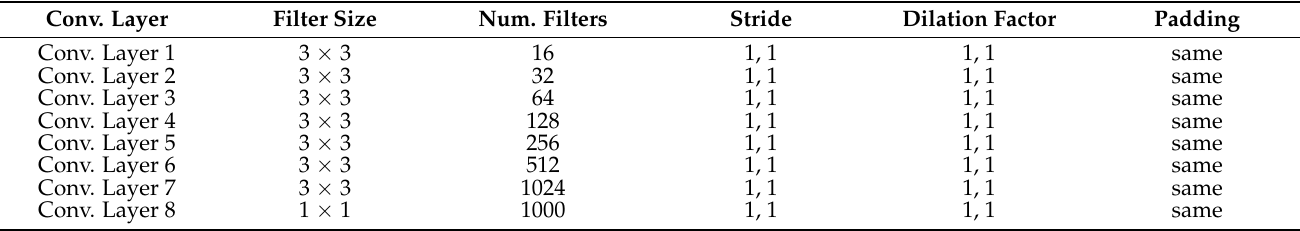
Table 3. Detail of the convolutional layers in the Darknet CNN. Conv. Layer Filter Size Num.